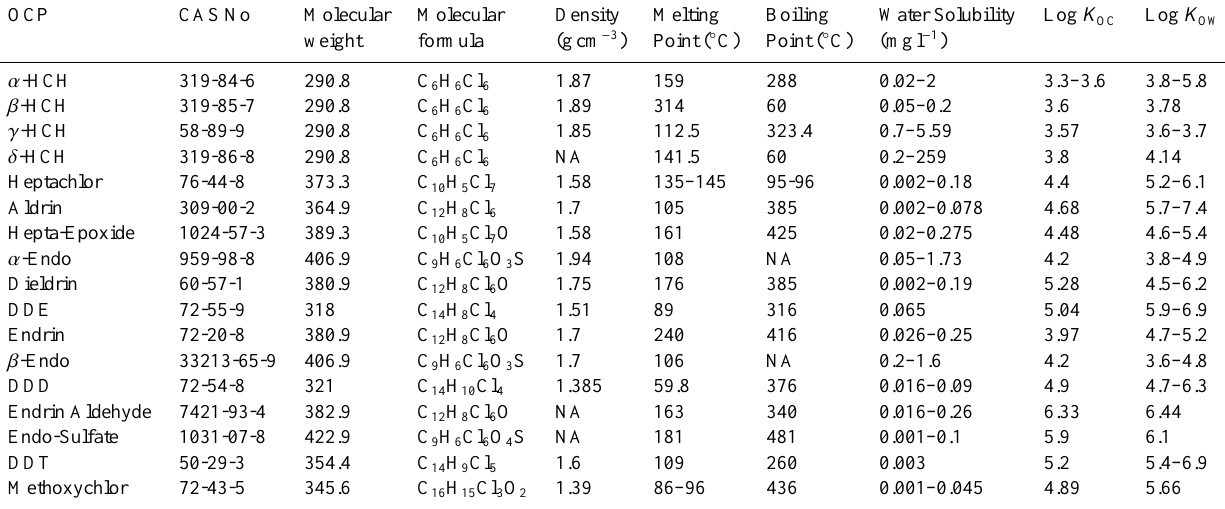
Table 3. Physico-chemical properties of investigated organochlorine pesticides.